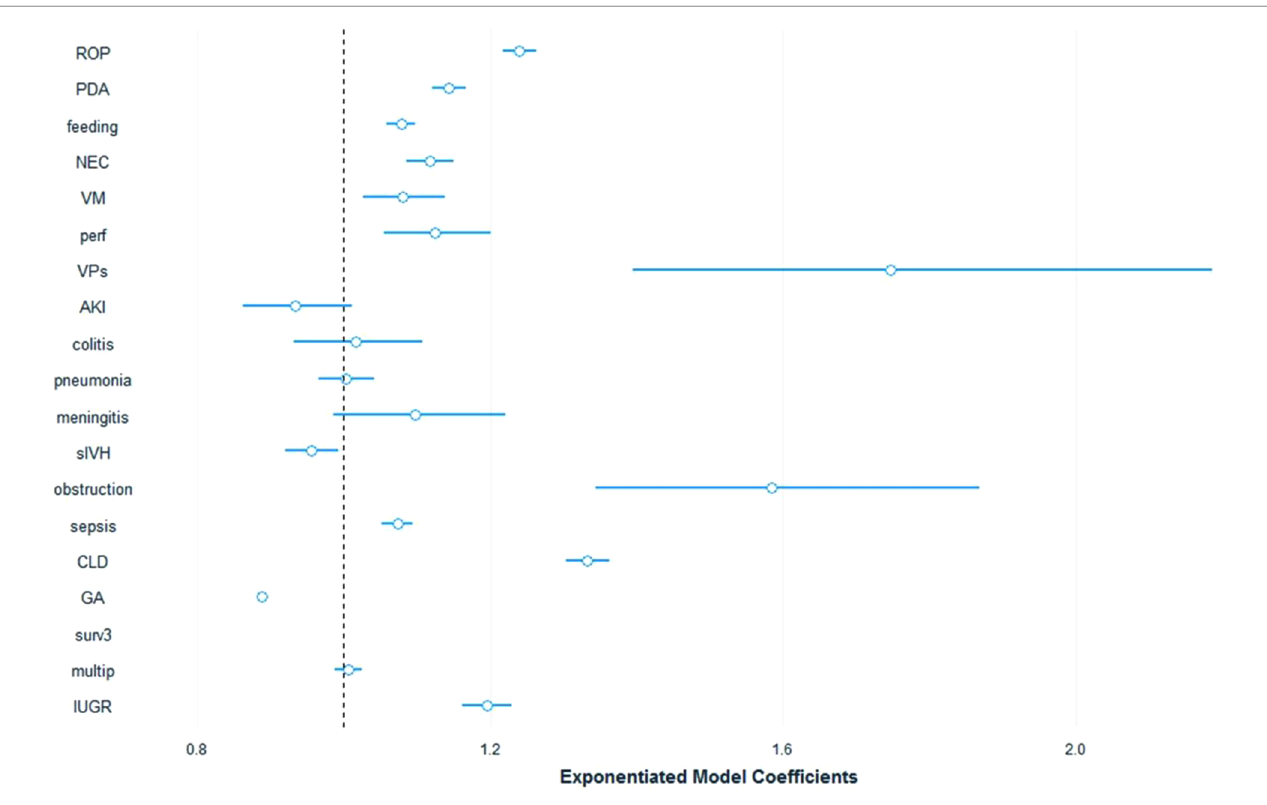
FIGURE 2 Cost model coeffecients plot. ROP, Retinopathy of prematurity; PDA, Patent Ductus Arteriosus; feeding, Feeding dif fi culties; NEC, Necrotizing Enterocolitis; VM, Ventriculomegaly; perf, Intestinal perforation; VPs, Ventriculoperitoneal Shunt; AKI, Acute Kidney Injury; colitis, non-NEC colitis; sIVH, Severe Intraventricular Haemorrhage; obstruction, Intestinal Obstruction; sepsis, Late Onset Sepsis; CLD, Chronic Lung